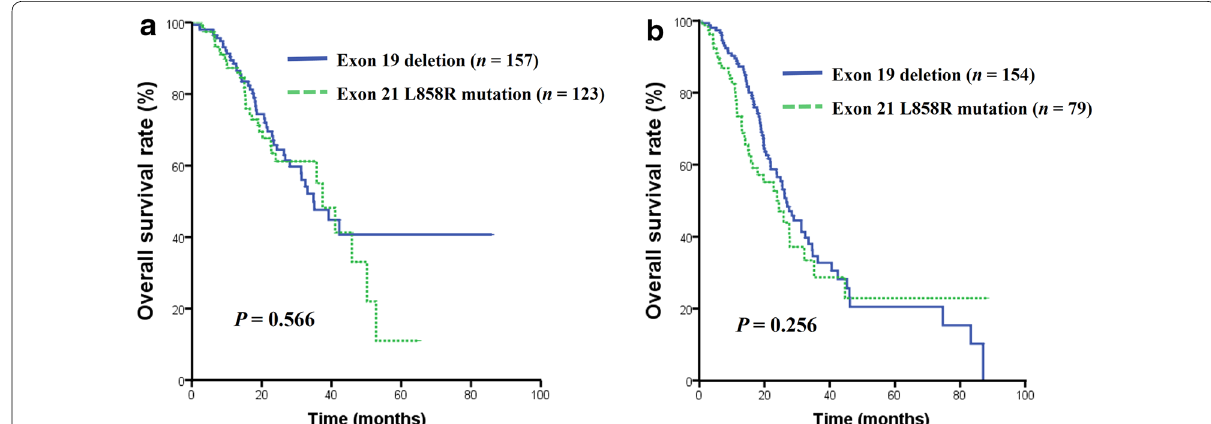
Fig. 2 Overall survival ( OS ) curves of EGFR ‑mutated patients treated with TKIs. a OS curves of patients with EGFR 19 del and L858R mutation who received first‑line TKI therapy (34.9 vs. 37.5 months, P second‑line or greater TKI therapy (26.7 vs. 23.8 months, P